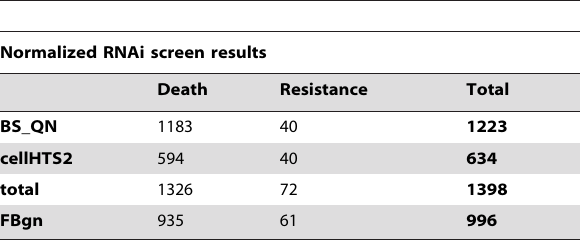
Table 1. Summary of MMS survival genes identified by genome-wide RNAi screen.